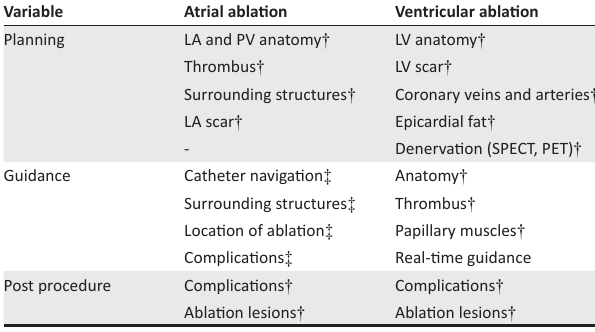
TABLE 1: Role of imaging